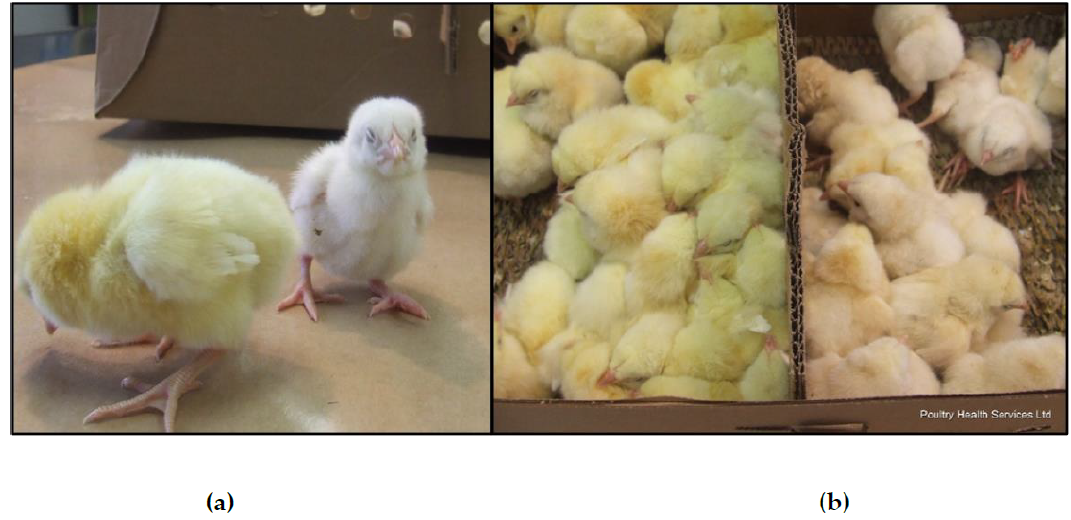
Figure 1. Hatching of normal (yellow) and a ff ected (white) chicks. Progenitor broiler breeders had a drop in production, and low hatchability (case 14-1235). Apparently normal chick on the left and an a ff ected “white chick” on the right in ( a ). Chick box after quality check containing apparently normal chicks on the left, and a ff ected chicks on the right ( b